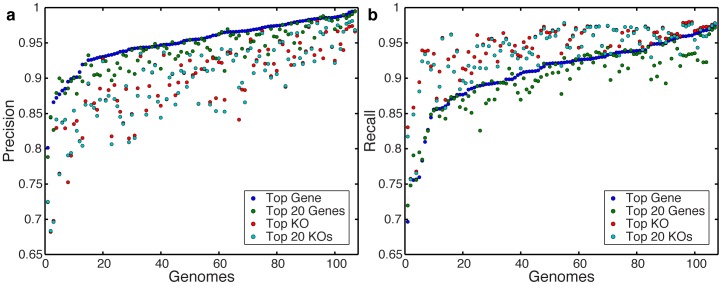
Comparison of annotation protocols for analyzing BLAST results.The (a) precision and (b) recall are illustrated for several protocols for identifying reads originating from KO genes when the strain from which the reads originated is absent from the database. Genomes are ordered by their precision and recall, respectively, using the top gene protocol.